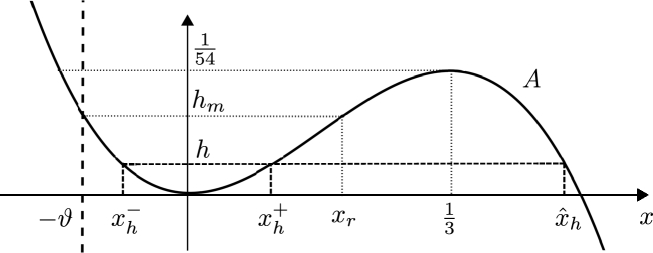
Root distribution of h−A(x)=(x−xh−)(x−xh+)(x−xˆh) in the proof of Lemma 3.9.